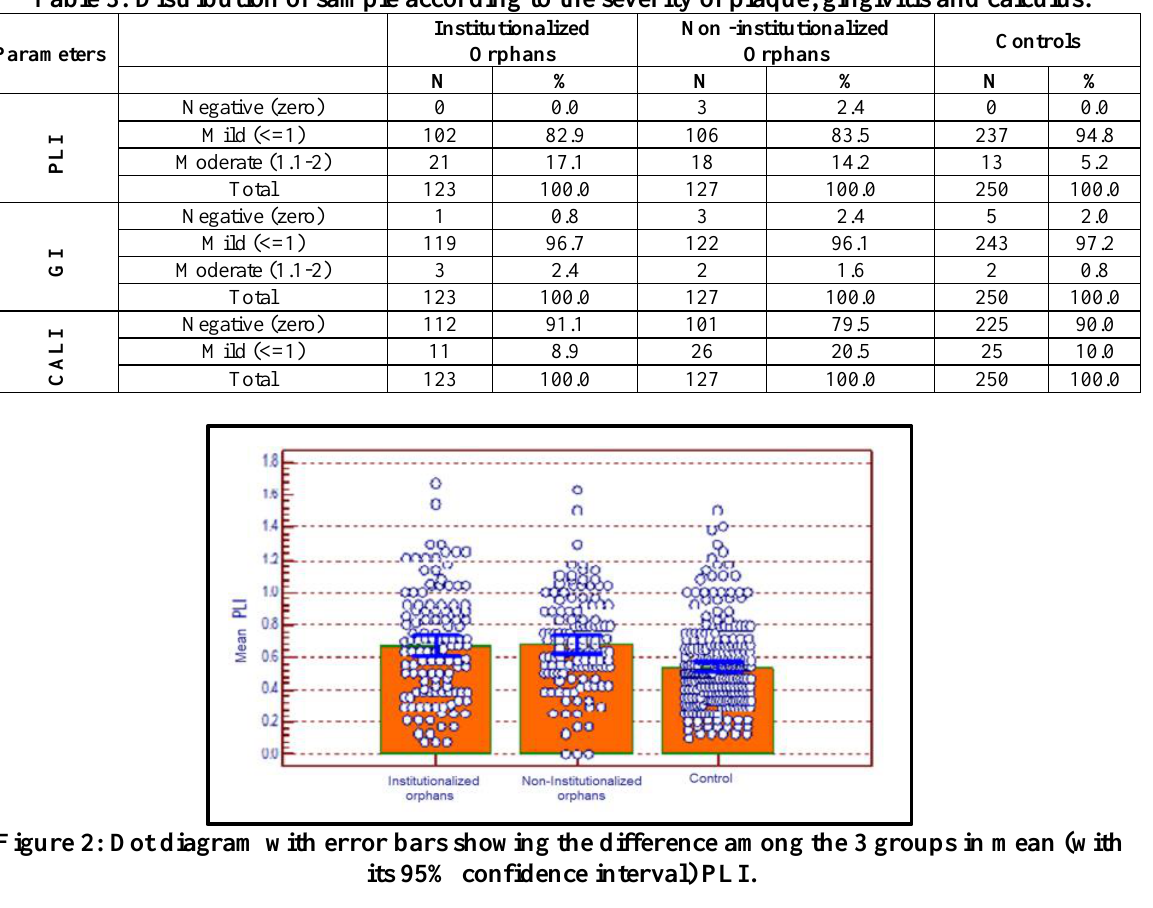
Table 3: Distribution of sample according to the severity of plaque, gingivitis and calculus. Parameters